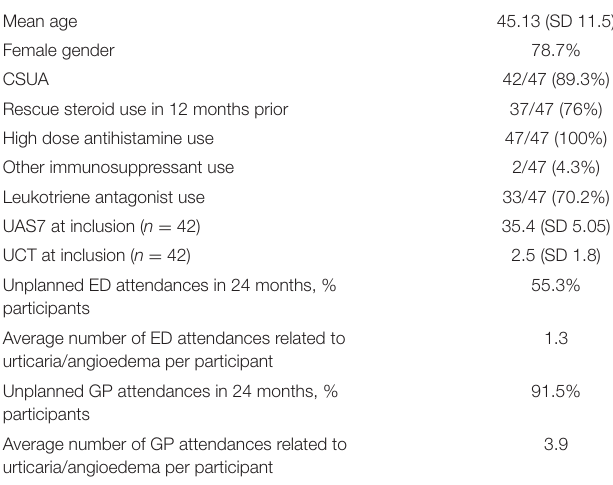
TABLE 1 | Baseline characteristics, n =